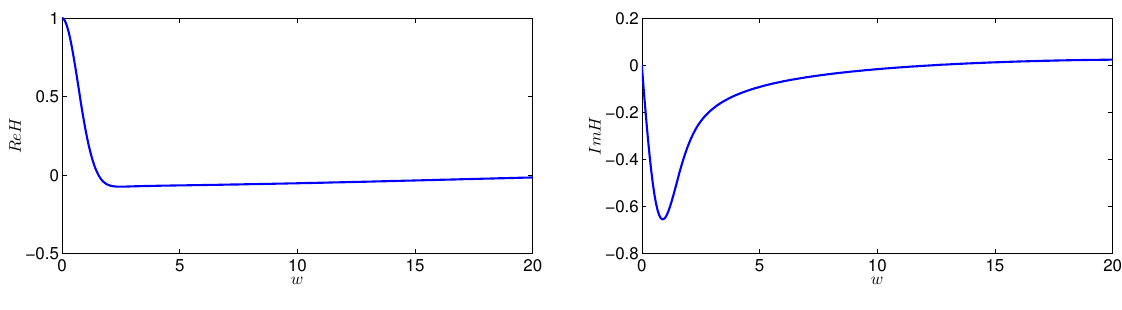
Figure 13. Re H ( w ) and Im H ( w ) in Dawson’s integral example using N = 300 sample points.